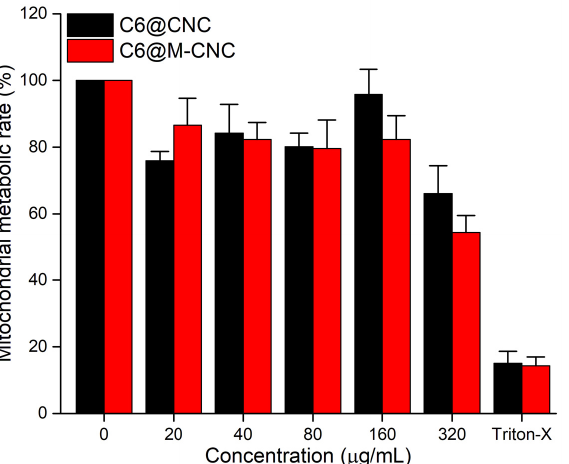
Figure 6. MTS assay of C6@CNCs and C6@M-CNCs (0–320 µg/mL) in Caco-2 cells. Triton ® -X (0.001%) was the positive control. Results are expressed as a % of negative control (0 µg/mL) and plotted as mean ± SEM ( n = 3).